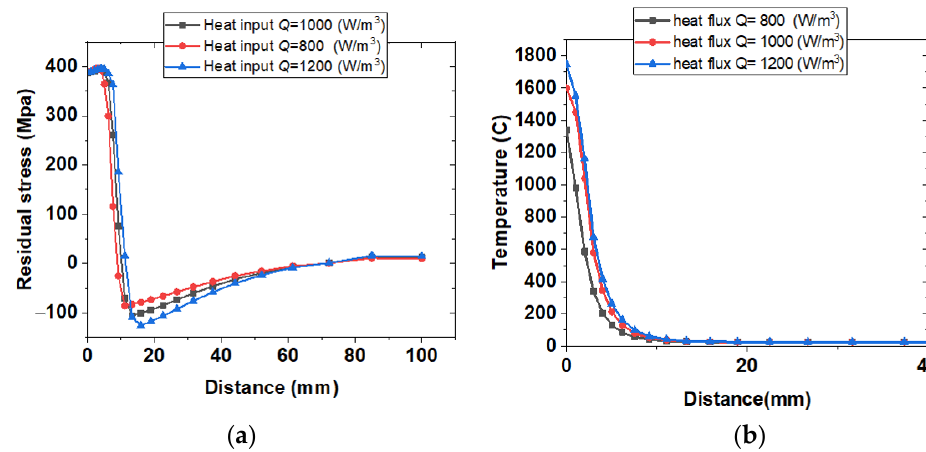
Figure 11. ( a ) RS along the transverse direction, ( b ) Temperature